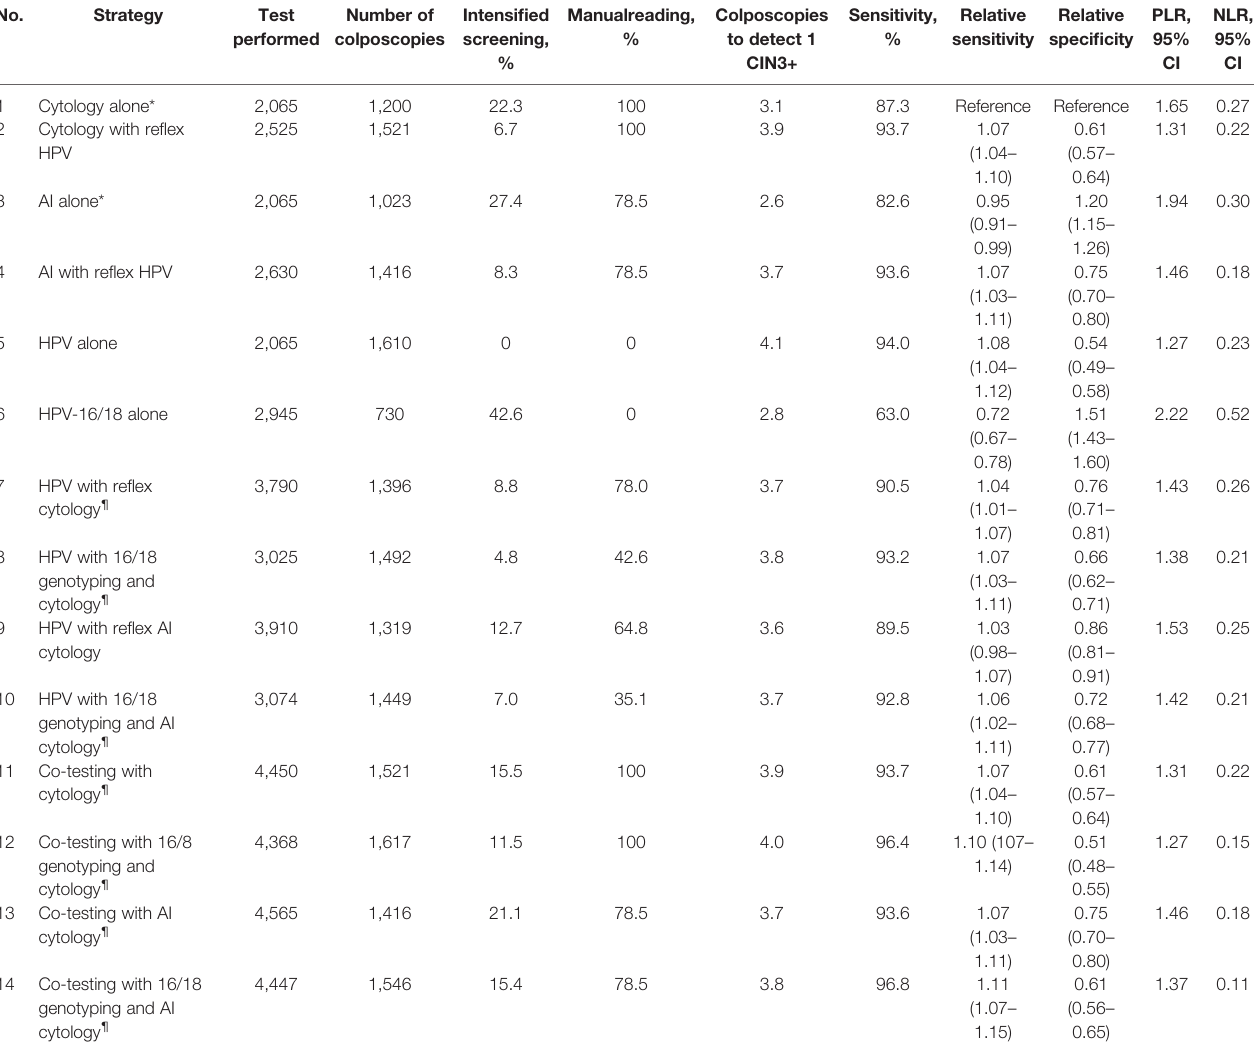
TABLE 3 | Clinical performance of different screening strategies for the detection of CIN3+.